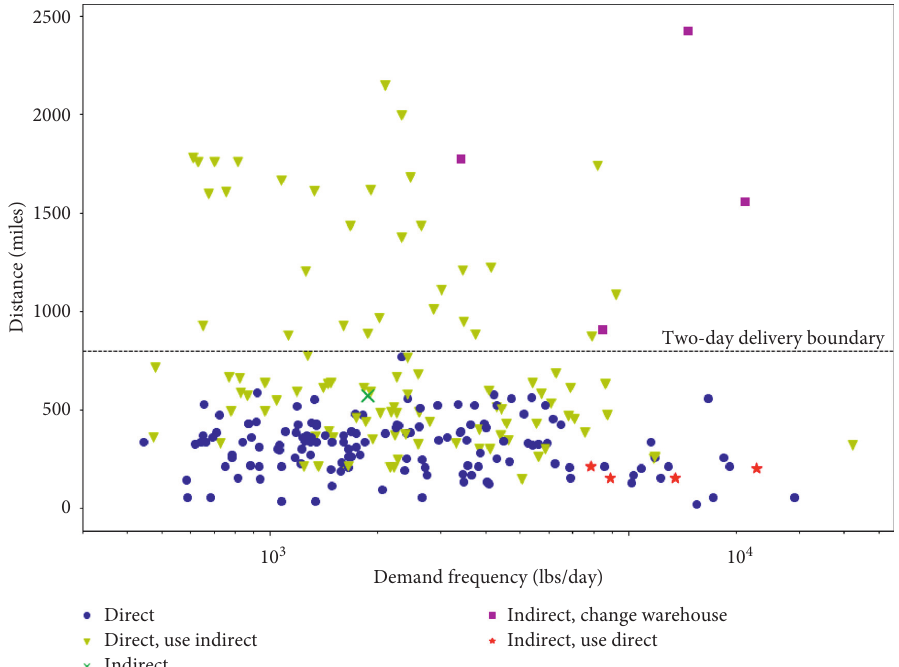
Figure 5: Optimal strategies for the customers shown on the customer space (distance versus demand frequency). Blue circles and green x’s show customers correctly serviced by direct and indirect strategies. The rest shows the serviced strategies that must be changed to optimize the freight